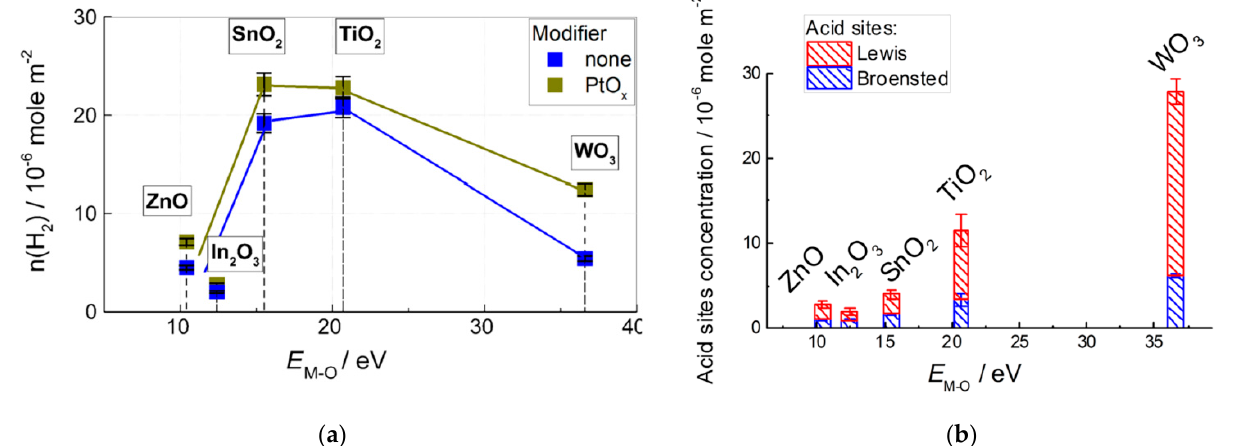
Figure 4. Concentration of oxidative sites at the surface of pristine and PtO x − modified MOS in equivalent amount of consumed H 2 for surface species reduction in TPR ( a ) and concentration of Broensted and Lewis acid sites at the surface of MOS determined by TPD of ammonia ( b ) in relation to metal–oxygen bond energy in MOS.